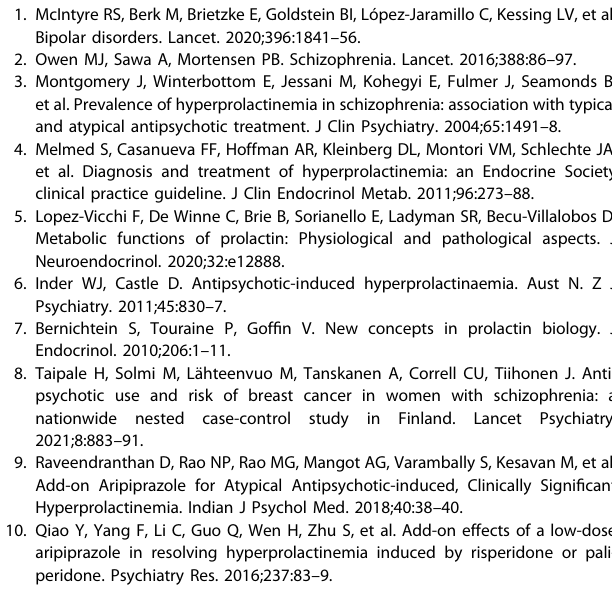
Fig. 4 Subgroup analyses of network meta-analysis. A Network plot and league table of comparison of pharmacological treatment strategies in treatment of patients with antipsychotic-induced hyperprolactinemia less than 50 ng/ml; B network plot and league table of comparison of pharmacological treatment strategies in treatment of patients with antipsychotic-induced hyperprolactinemia more than 50 ng/ml; C network plot and league table of comparison of pharmacological treatment strategies in treatment of patients with antipsychotic- induced hyperprolactinemia more than 100 ng/ml. ARI_5 mg adjunctive 5 mg aripiprazole, ARI_10 mg adjunctive 10 mg aripiprazole, ARI_more_10 mg adjunctive more than 10 mg aripiprazole, MET adjunctive metformin, PGD adjunctive Peony-Glycyrrhiza decoction, switch_ARI_ fi xed_im switching to ARI with fi xed dosage and reducing the previous antipsychotic immediately, switch_ARI_ fi xed_ta switching to ARI with fi xed dosage and reducing the previous antipsychotic in tardation, switch_ARI_ti_ta switching to ARI in titration and reducing the previous antipsychotic in tardation, VitB6 adjunctive high-dose vitamin B6. The color of each cell indicates the certainty of evidence according to the Grading of Recommendations Assessment, Development, and Evaluation. Red color refers to very low certainty of evidence, yellow color refers to low certainty of evidence, green color refers to moderate certainty of evidence, blue color refers to high certainty of evidence. The signi fi cant outcomes were shown in